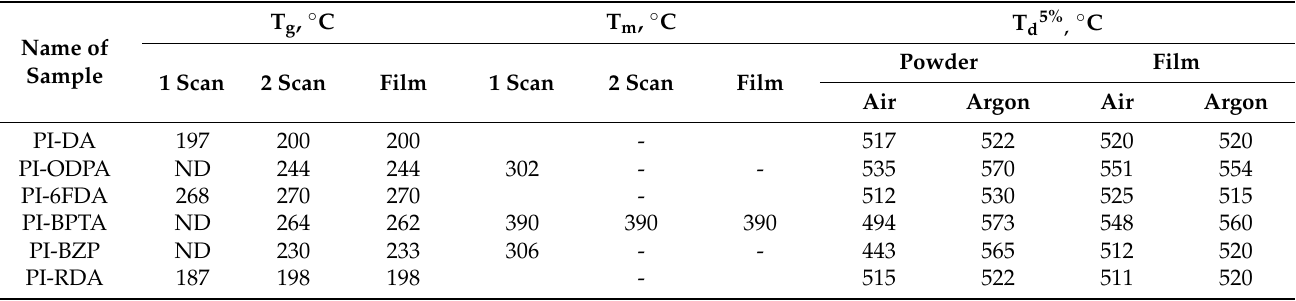
Figure 8. TGA curves of polyimides powder (in air atmosphere, 10 °C/min). Table 4. Thermal properties of obtained PIs.